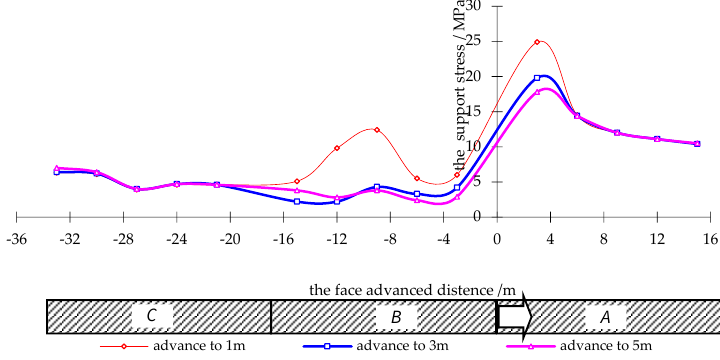
Figure 5. Key block dynamic load change in mining.